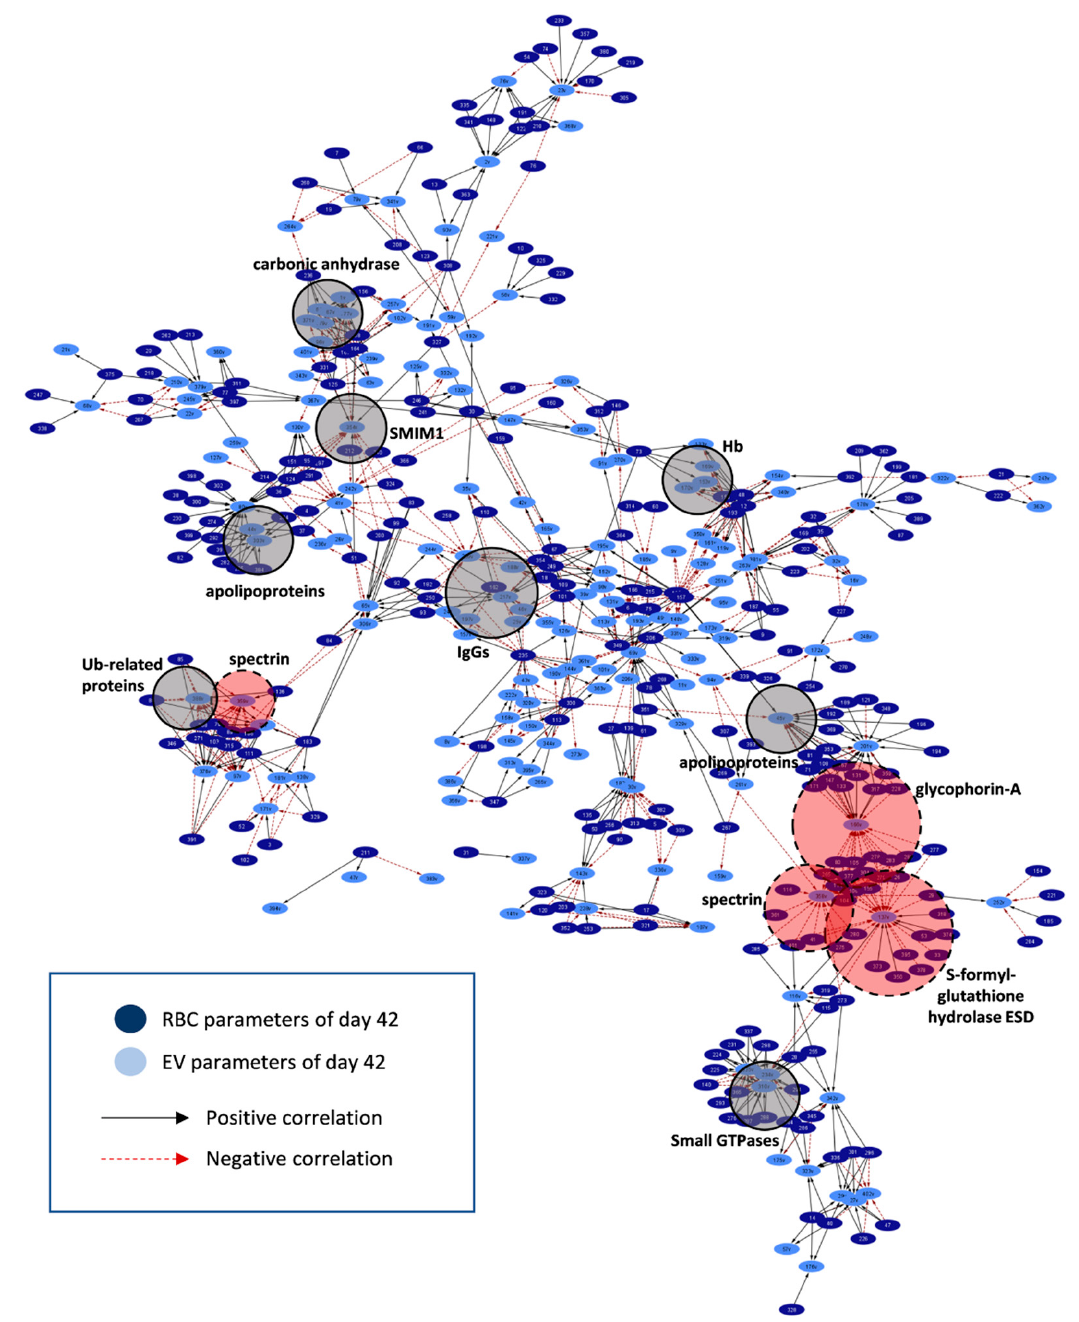
Figure 10. Network connecting RBC to EV parameters in control RBC units on day 42 of storage. Interactome based on the correlation coefficient R values between parameters of stored RBCs and EVs in late storage. The length of each edge is inversely proportional to the R value (the shorter the edge, the higher the R value). All connections are statistically significant at p < 0.01. Solid light grey circles focus on high connectivity hubs found in both donor groups. Dashed red circles highlight representative high connectivity hubs that predominate in the control network. For abbreviations, see Table S6.